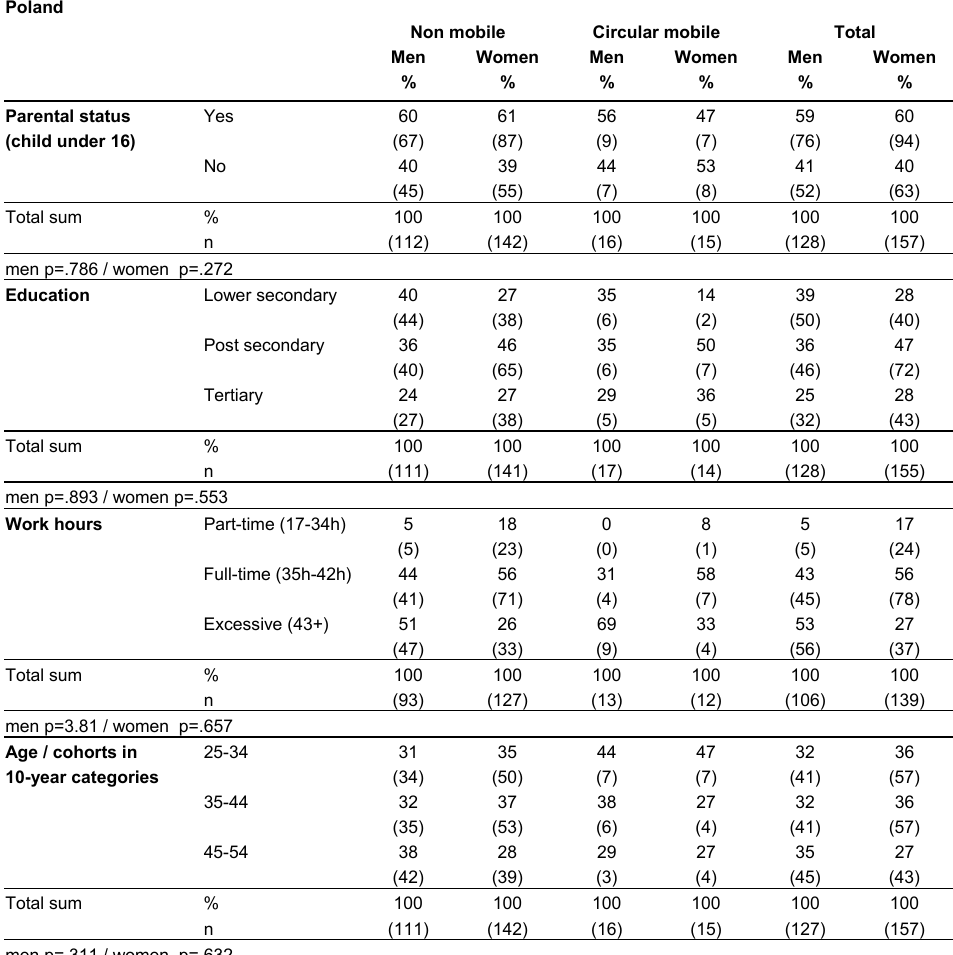
Table 2: Frequencies of Polish men and women, living in partnerships, by mobility status